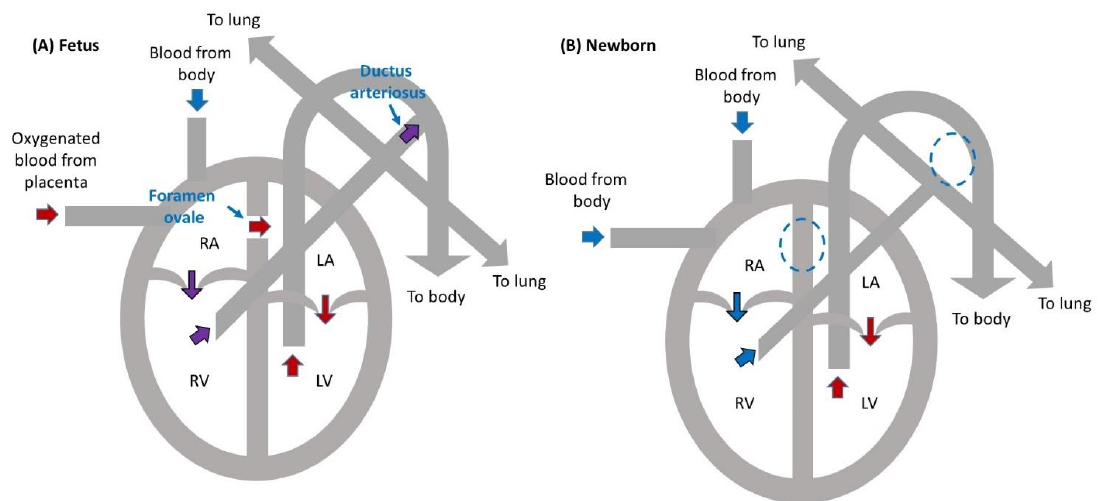
Figure 2. Heart circulation in a fetus and newborn baby. ( A ) Fetal circulation. The right and left atria are connected by the foramen ovale. The ductus arteriosus redirects blood from the pulmonary circulation to the systemic circulation. Oxygenated blood from the placenta is then directed to the left atrium (LA), through the left ventricle (LV), and to the systemic circulation. The lungs are bypassed. ( B ) Newborn circulation. The foramen ovale and ductus arteriosus close soon after birth (broken circles indicate fetal location), separating the right heart, which directs deoxygenated blood (in blue) from the body to the lungs for oxygenation; from the left heart, which pumps oxygenated blood (in red) from the lungs to the body. RA: right atrium; LA: left atrium; RV: right ventricle; LV: left ventricle.